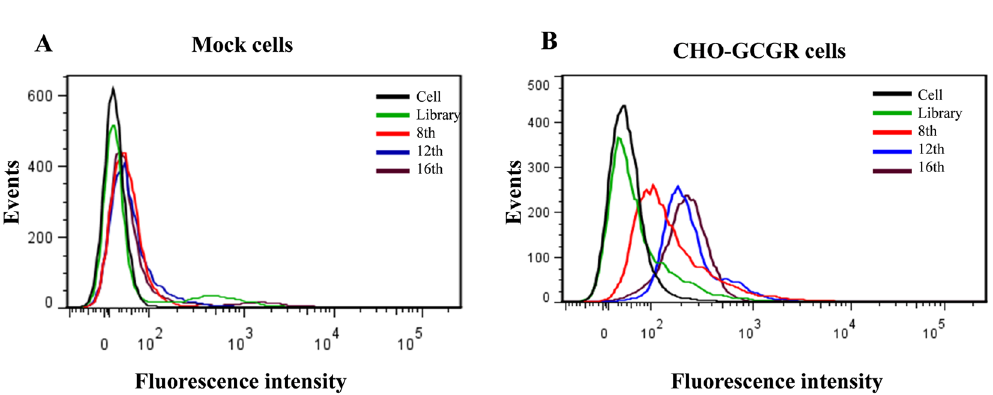
Figure 1. Scheme of cell-SELEX for GCGR-expressing CHO-K1 cells (CHO-GCGR). The ssDNA library was incubated with Mock cells as negative selection to remove the cell-binding ssDNA. The unbound ssDNA was incubated with GCGR-expressing CHO-K1 cells (CHO-GCGR) for positive selection. After washing, the bound DNA was eluted and amplified by PCR for next-round selection. The evolved ssDNA pool was sequenced to identify the aptamer candidates in the last round of selection.